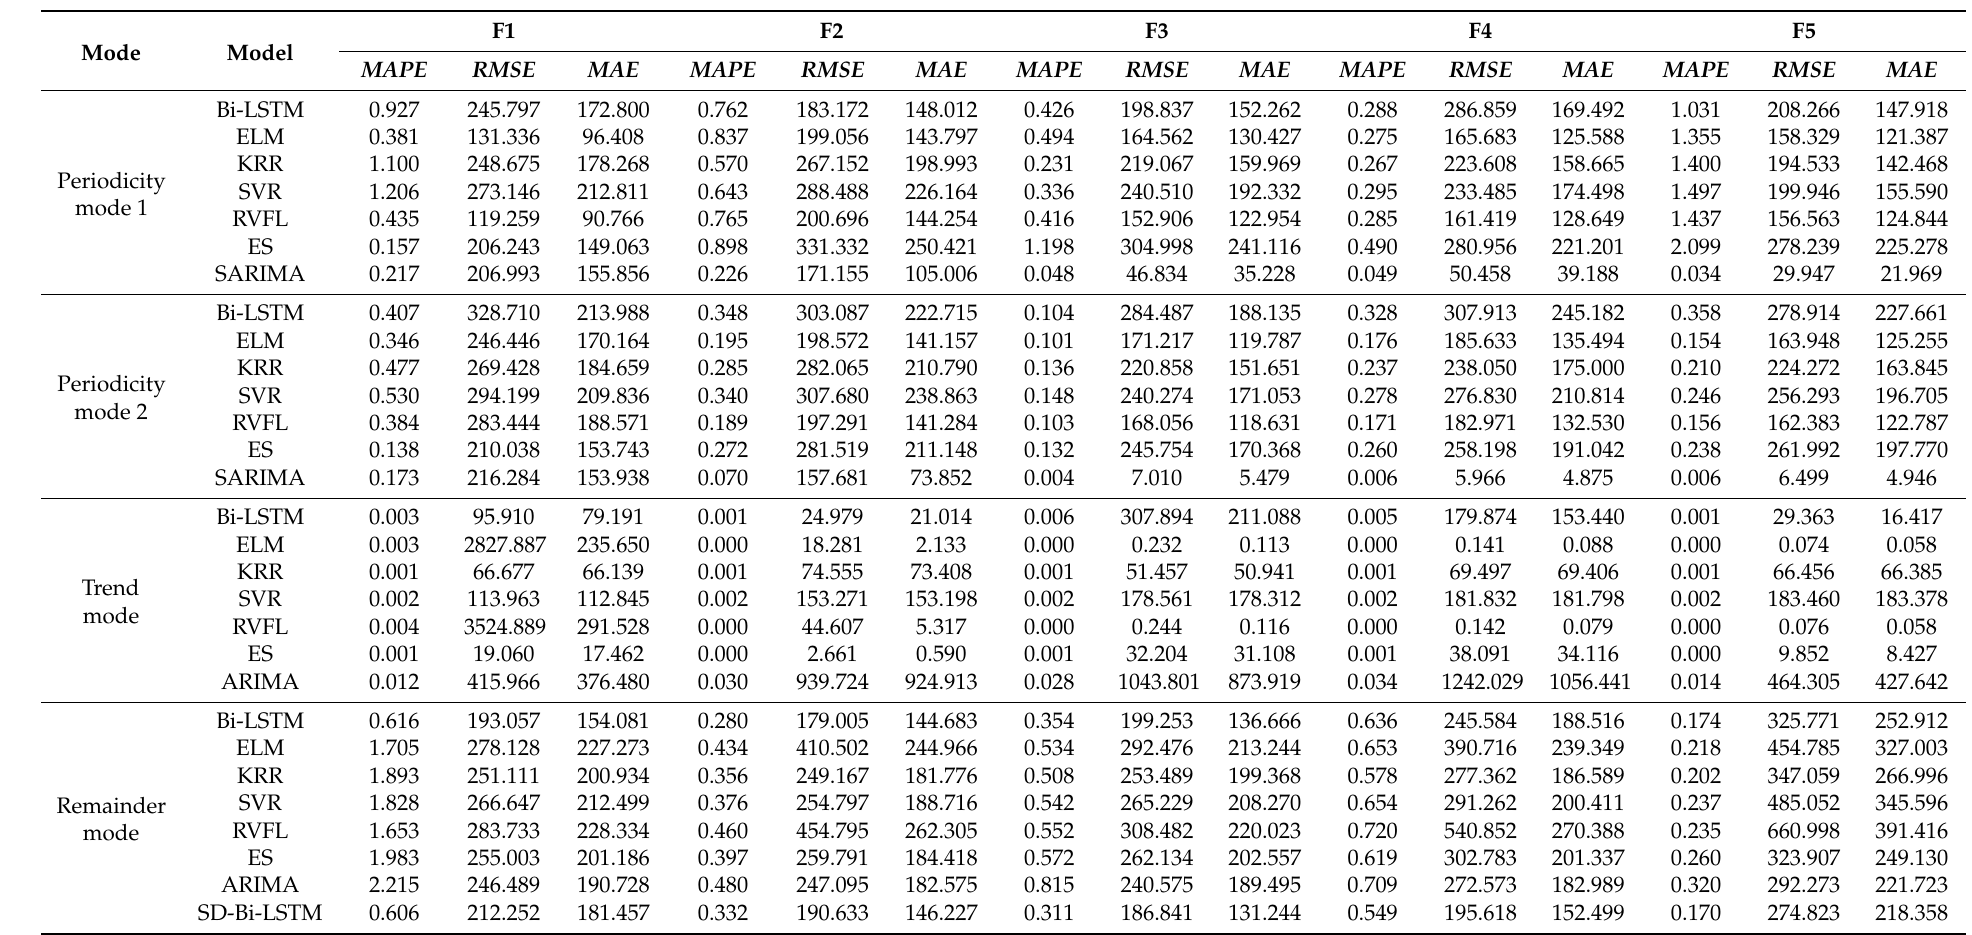
Table 4. Prediction performance of the candidate models on each